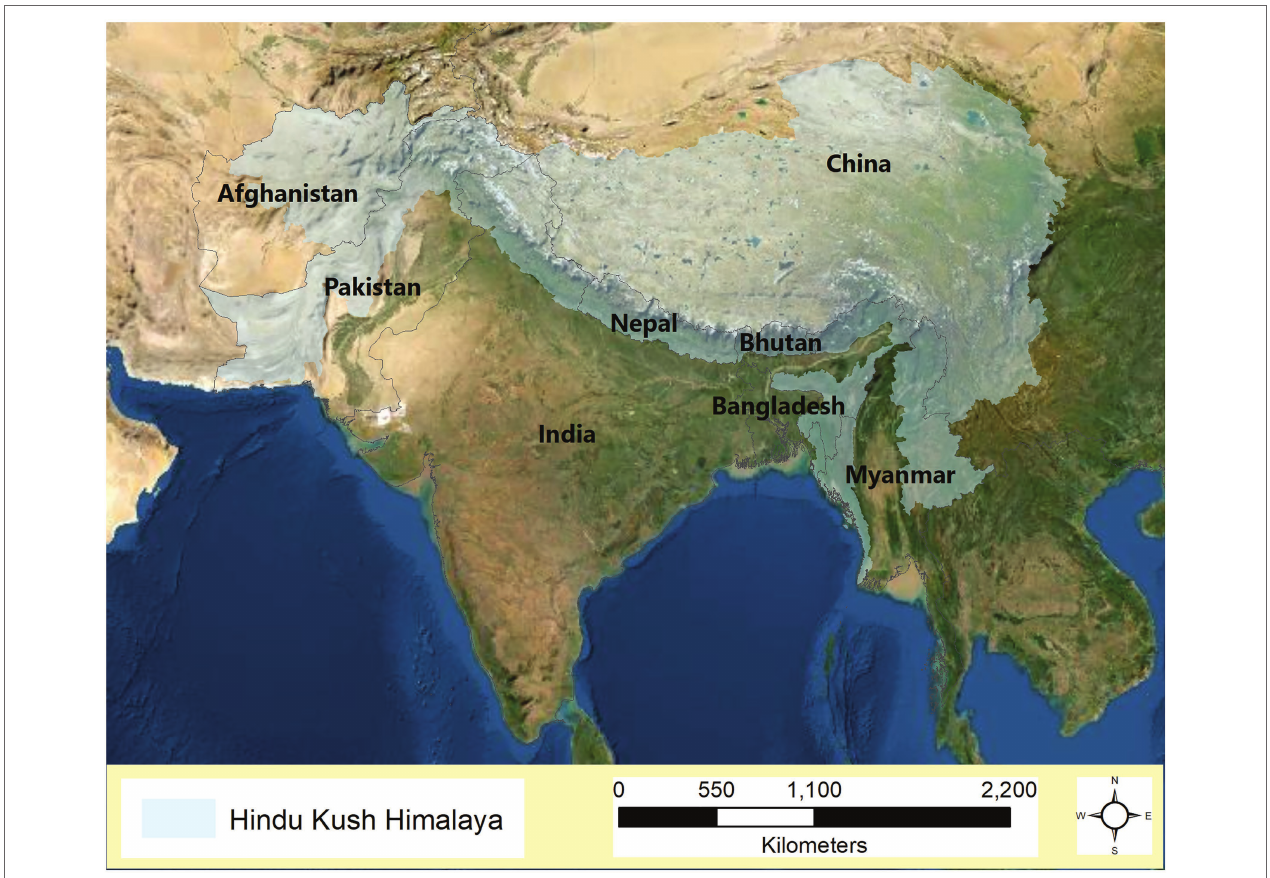
FIGURE 1 | Map showing Hindu kush Himalayan